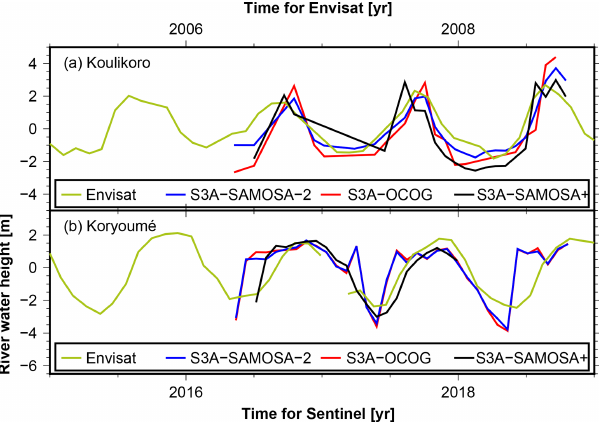
Figure 7. River water height anomaly from Sentinel-3A (S3A) at two stations compared to Envisat data (pass 646 for Koulikoro and pass 459 for Koryoumé) measured 10 years earlier (green). The S3A solutions (pass 87 for Koulikoro amd pass 244 for Koryoumé) are the Copernicus Hub Land (blue and red) and the G-POD solutions